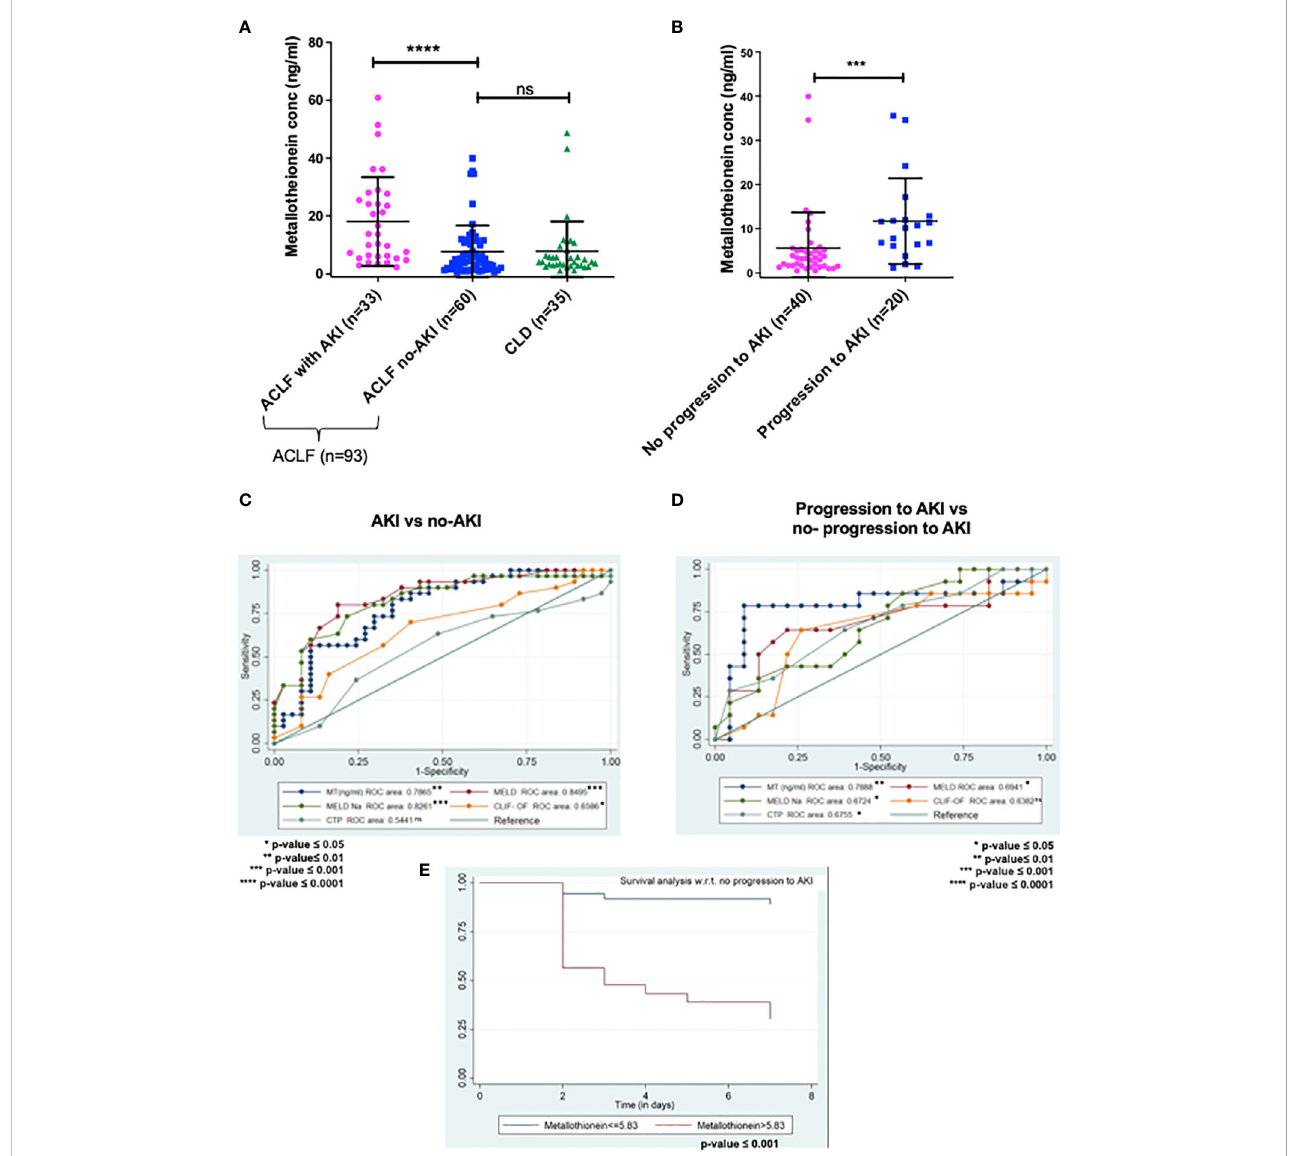
FIGURE 2 ELISA validation of plasma metallothionein (MT) levels in day-of-admission plasma from ACLF and CLD patients. (A,C) MT levels are signi fi cantly higher in ACLF-AKI patient plasma as compared to ACLF no-AKI or CLD with an AUROC of ~ 0.7865 (p- value ≤ 0.0001); (B, D) MT levels are signi fi cantly higher in plasma of ACLF patients who progress to AKI vs those who do not with an AUROC of ~0.7888 (***p-value ≤ 0.001; ****p-value ≤ 0.0001). (E) Kaplan- Meier analysis for progression/no-progression to AKI for ACLF patients with plasma MT concentrations > 5.83 ng/mL (p-value <0.0001). ns = non-signi fi